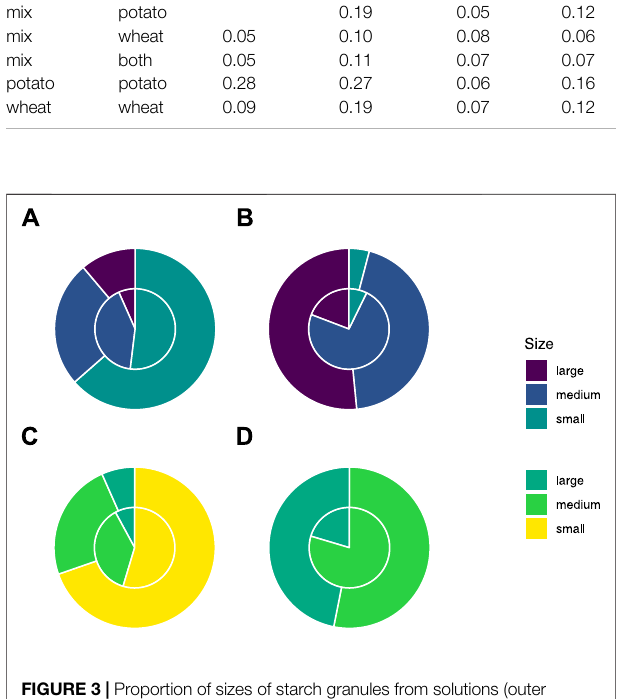
FIGURE 3 | Proportion of sizes of starch granules from solutions (outer ring) and treatment samples (inner ring) in separated wheat (A) and potato (B) treatments, and mixed wheat (C) and potato (D)